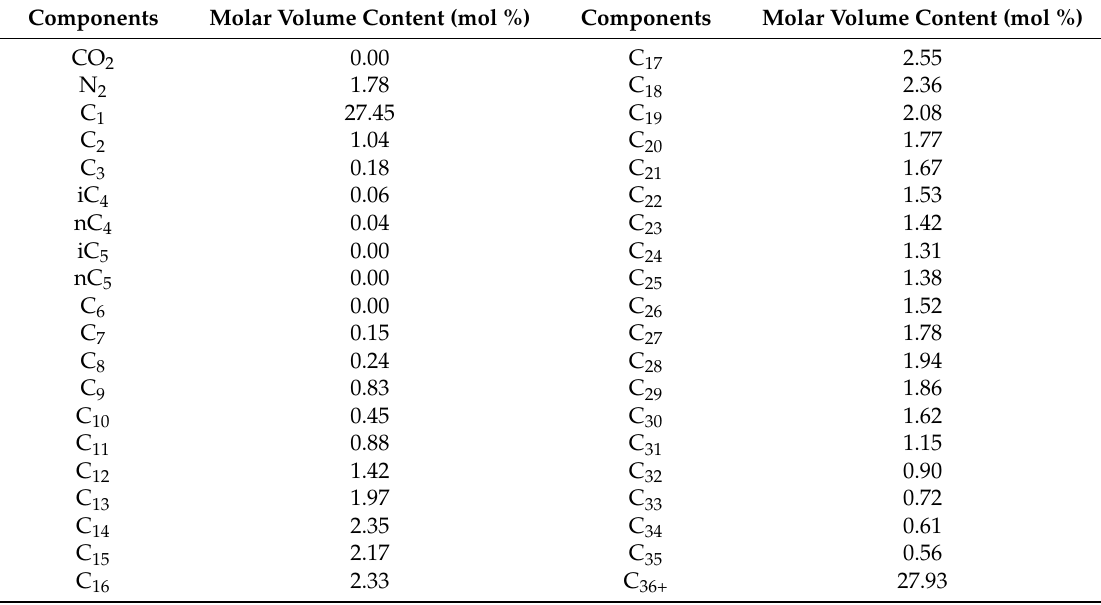
Table 1. Composition of crude oil in a shallow reservoir.